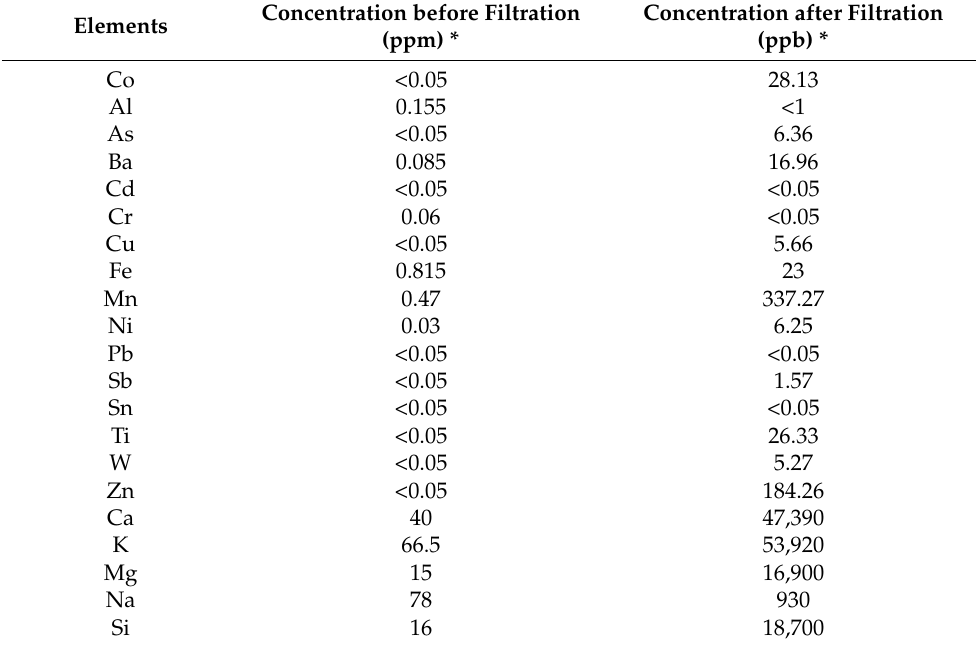
Table 2. Ion concentration in the real water sample.